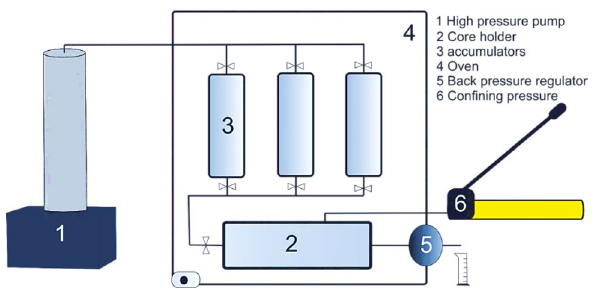
Fig. 7 Schematic representation of the core-flooding